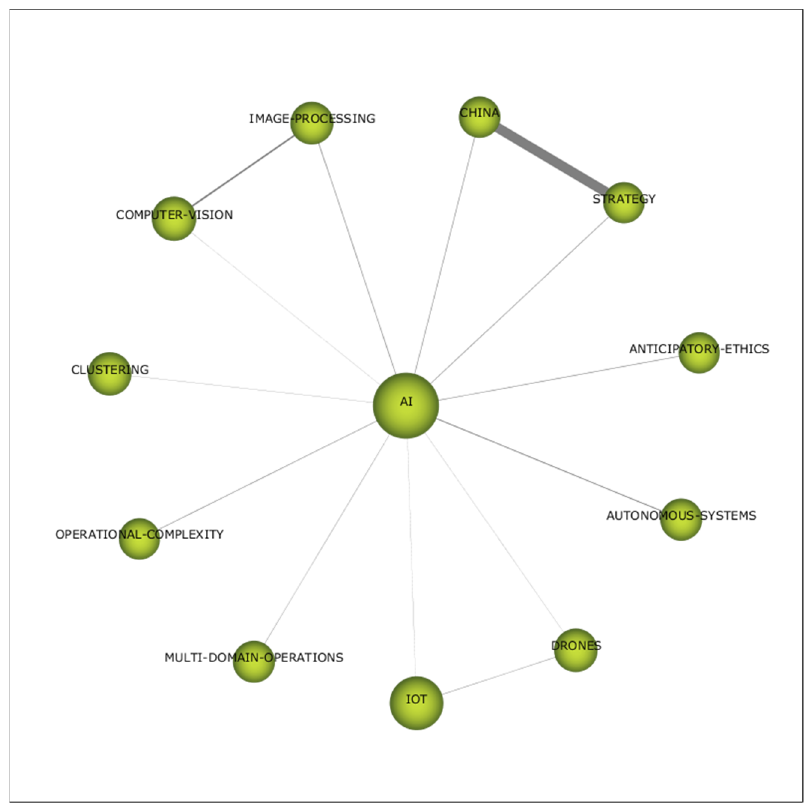
Figure 13. Category: AI, robotics and smart devices; From 2016; Theme: Artificial intelligence.